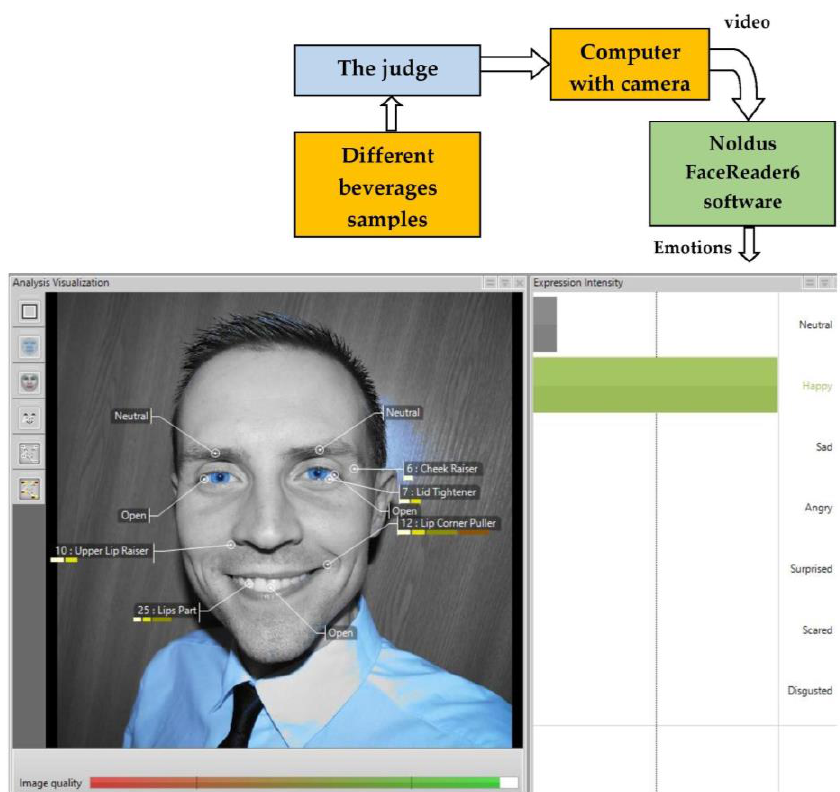
Figure 1. Analysis of the emotions induced by the final beverages using the FaceReader 6 software (Noldus Information Technology, Wageningen, The Netherlands), and further scoring the 8 emotion patterns: neutral, happy, sad, angry, surprised, scared, disgusted and contempt [25,26].